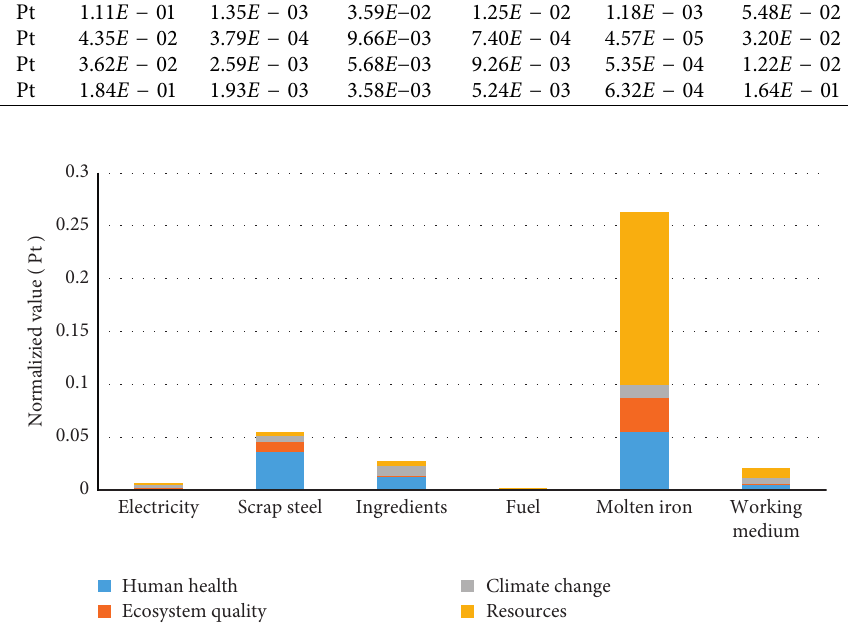
Figure 3: Single score result for 1t molten steel.